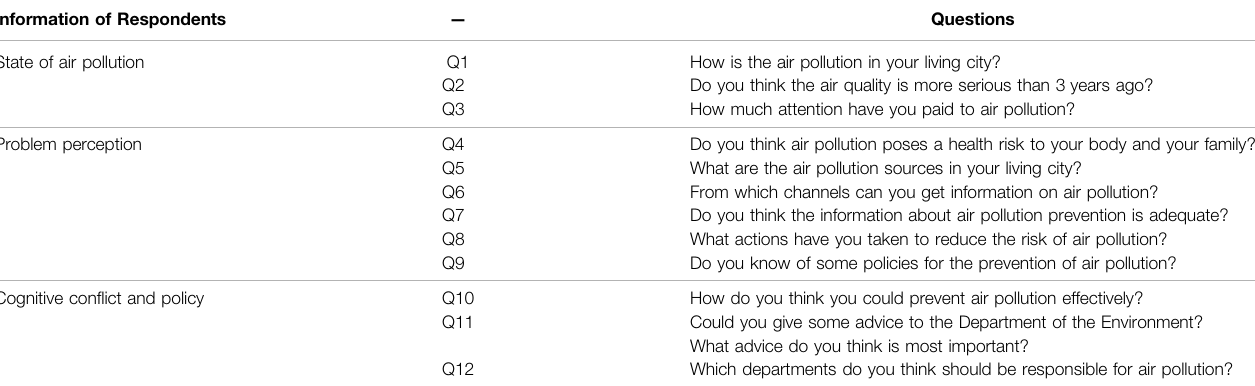
TABLE 1 | Illustration of stakeholders ’